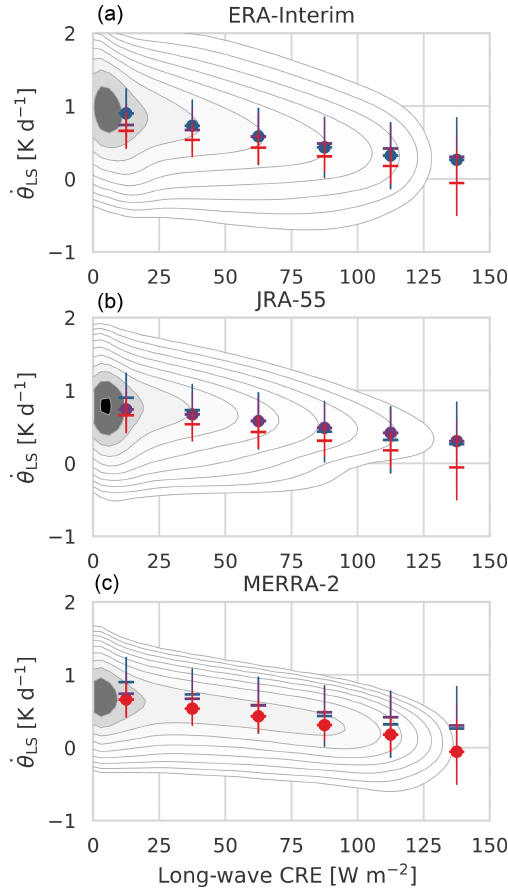
Figure 11. Joint distributions of daily-mean gridded diabatic heat- ing rates ( ˙ θ ) in the tropical lower stratosphere ( θ = 380K to θ = 460K) against the corresponding long-wave cloud radiative effect (LWCRE) based on ERA-I (a) , JRA-55 (b) and MERRA-2 (c) during 1980–2013. The LWCRE is calculated as clear-sky minus all-sky outgoing long-wave radiation. Also shown are means and standard deviations of ˙ θ LS composited into LWCRE bins in inter- vals of 25Wm − 2 starting from zero. Estimates based on ERA-I (blue), JRA-55 (purple) and MERRA-2 (red) are shown on all three panels to facilitate comparison. Distributions are based on vari- ables archived on 1 ◦ × 1 ◦ (ERA-I) and 1 . 25 ◦ × 1 . 25 ◦ (JRA-55 and MERRA-2) latitude–longitude grids between 30 ◦ S and 30 ◦